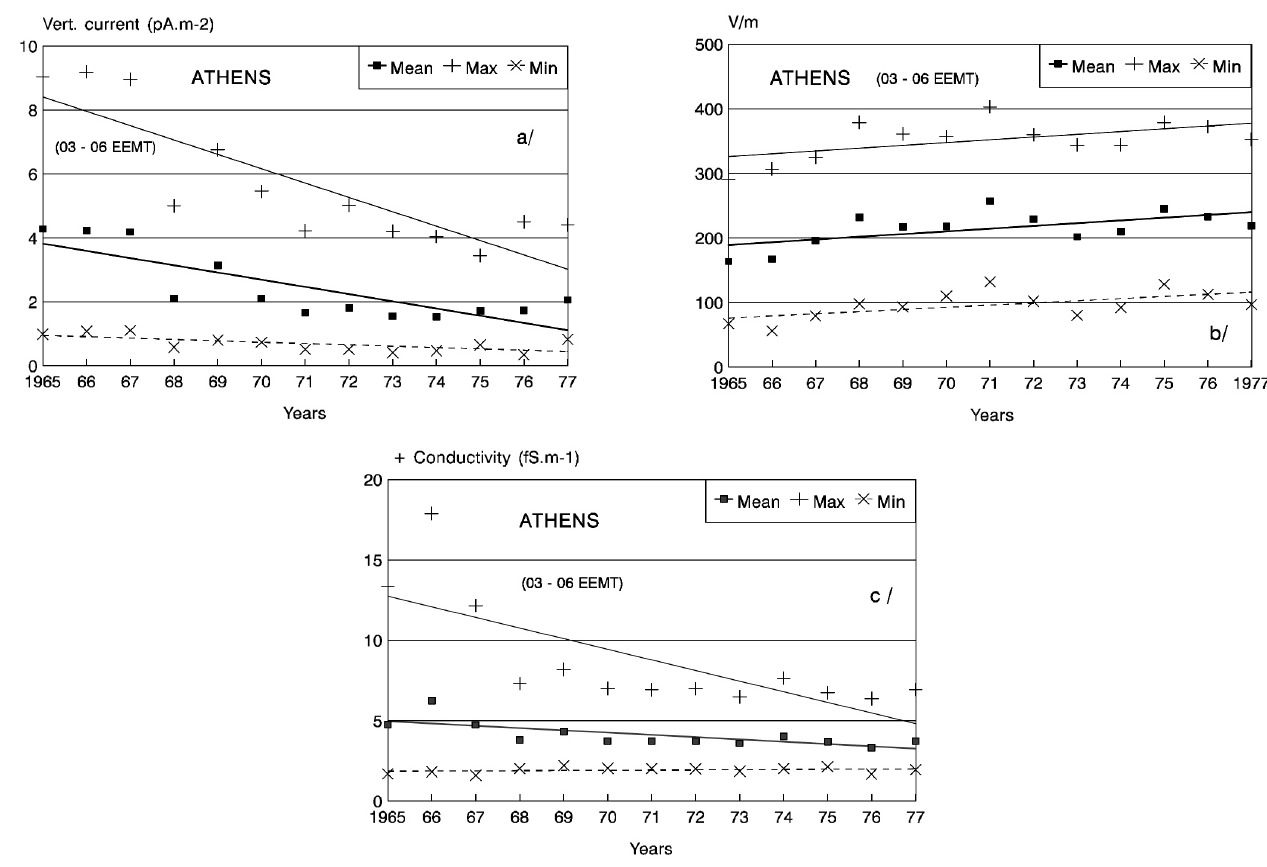
Fig. 2. (a) Changes in dawn values of air-Earth current density (based on data from 03:00 to 06:00 EEMT) derived for Athens between 1965 and 1977. (b) The same as in the case of air-Earth current density (a), but for the PG. (c) The same as in the case of (a) and (b) but for the positive